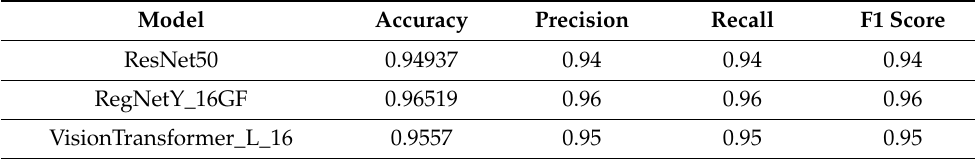
Table 4. Results for various models on DS-1 with CLAHE preprocess.